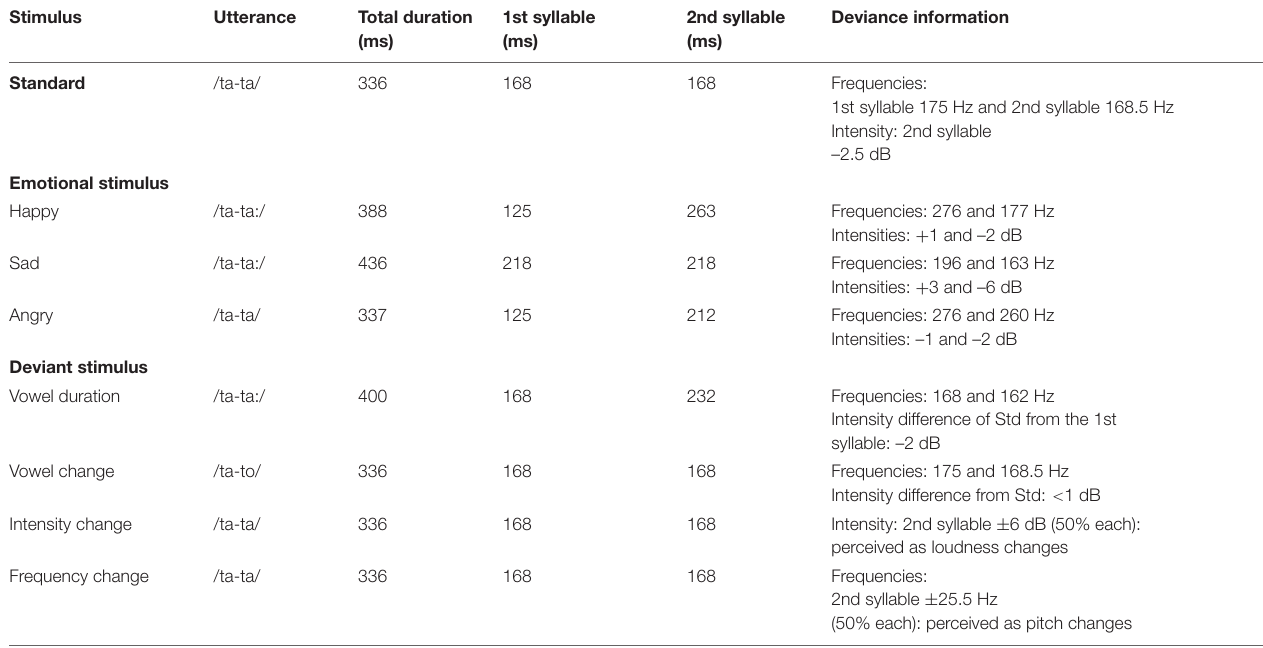
TABLE 2 | Detailed paradigm information. (a) The multi-feature paradigm with standard, deviant, and emotional stimuli (Pakarinen et al., 2014, same as in Kostilainen et al., 2018,